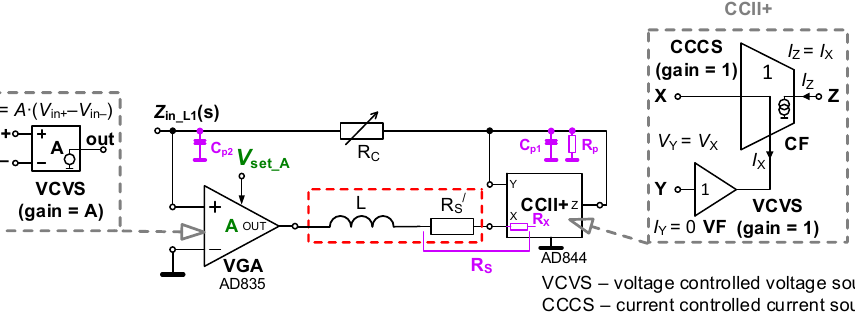
Figure 2. Topology of electronically adjustable inductance using VGA and CCII+ suitable for R S cancellation.